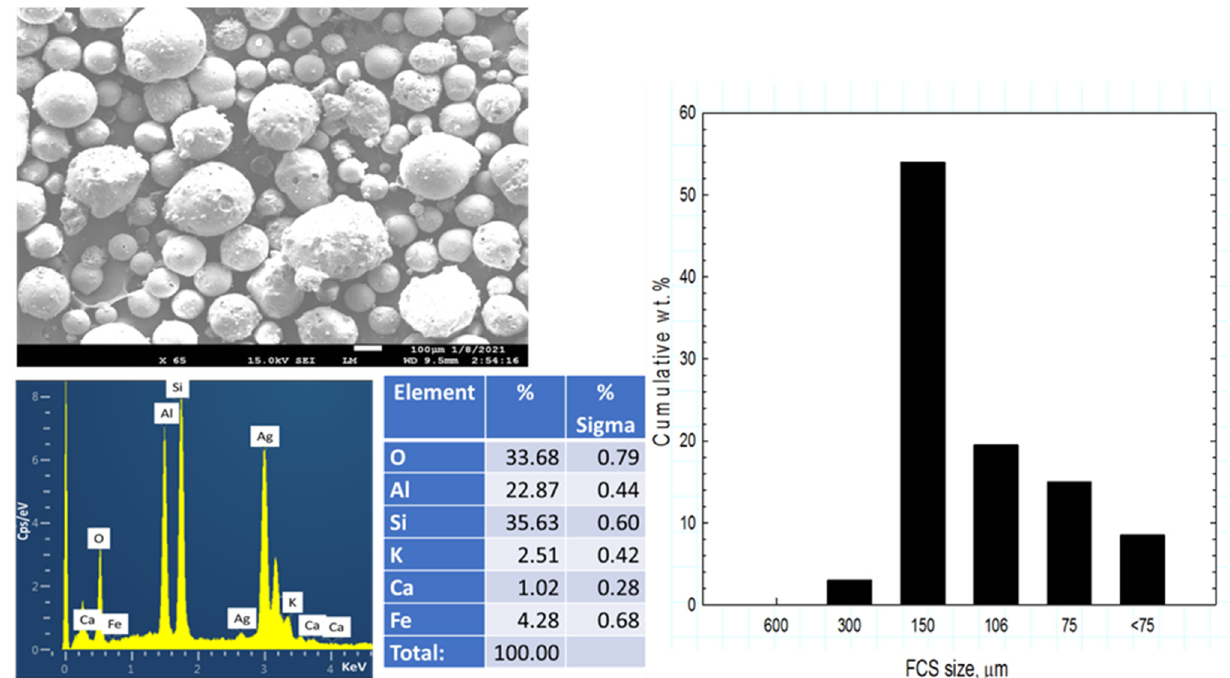
Figure 1. Photomicrograph, elemental analysis, and cumulative size distribution of tested FCS. Table 1. Oxide compositions of #80 CAC and Class F fly ash. Oxide Compositions, wt.%